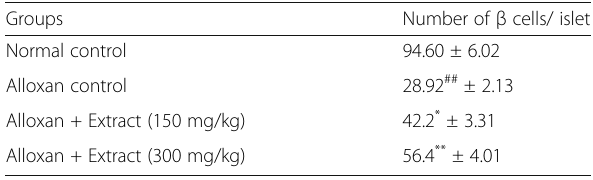
Table 3 The number of β cells per islet in the control